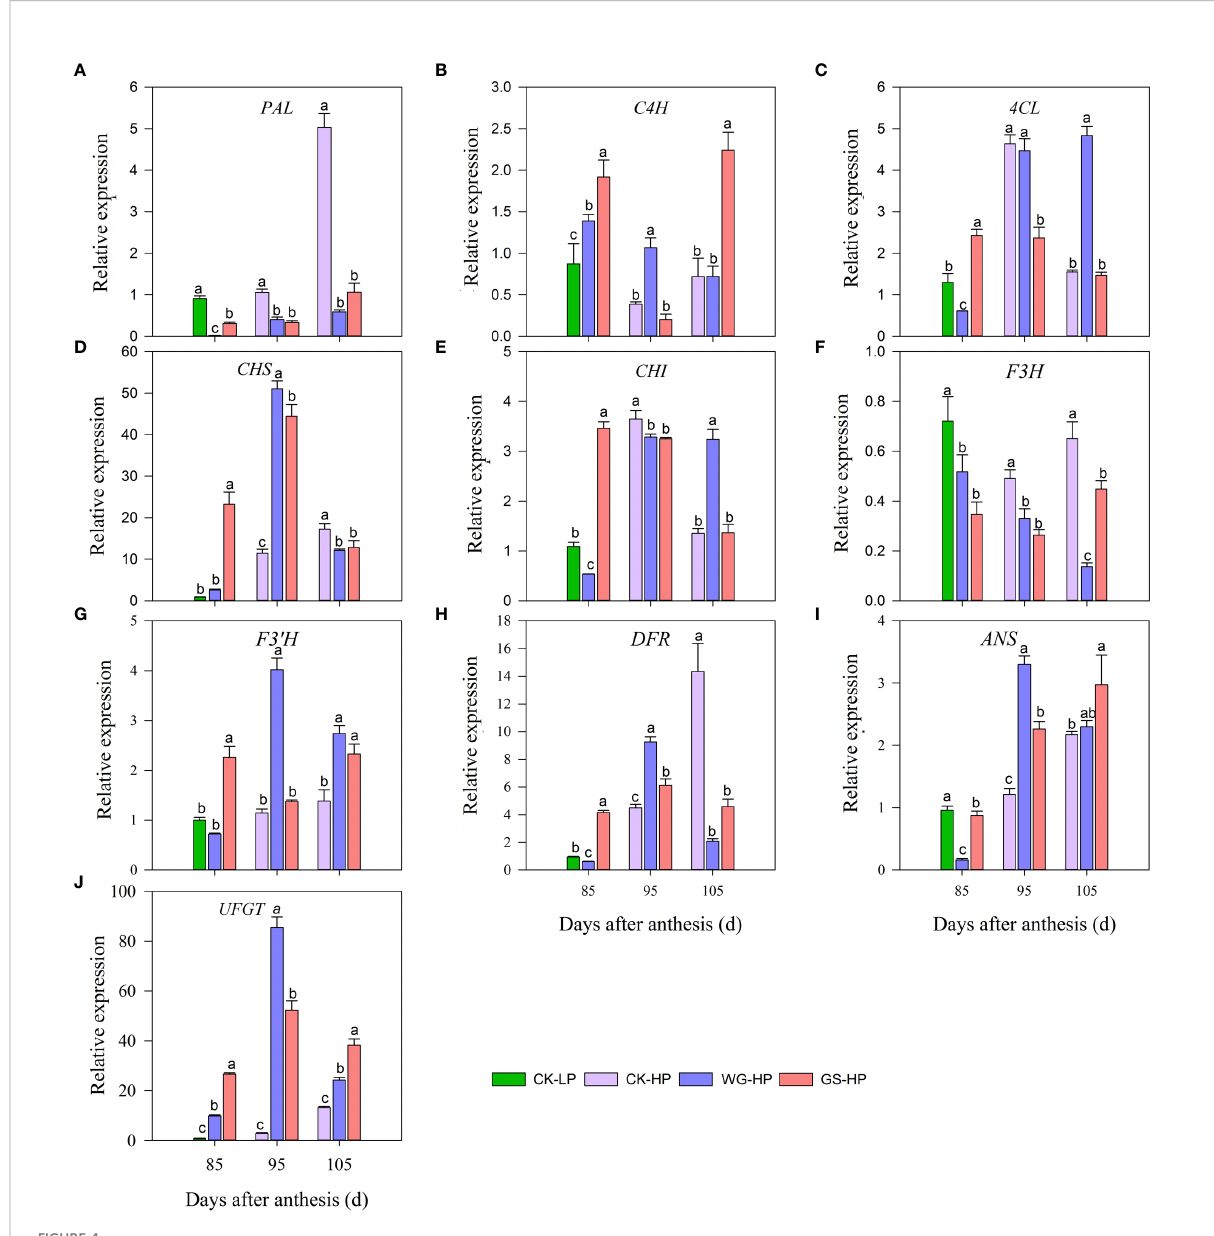
FIGURE 4 Transcript levels of anthocyanin-related genes in different treatments. CK-LP means green skin of ‘ Yinhongli ’ plum, the rest are red skin. Values are mean ± SD (n =3). Different letters indicate signi fi cantly different values at p < 0.05. Phenylalanine ammonialyase, PAL (A) , namate-4- hydroxylase, C4H (B) , 4-coumaroyl: CoA-ligase, 4CL (C) , chalcone synthase, CHS (D) , chalcone isomerase, CHI (E) , fl avanone 3-hydroxylase, F3H (F) , fl avanone 3 ′ -hydroxylase, F3 ’ H (G) , dihydro fl avonol 4-reductase, DFR (H) anthocyanidin synthase, ANS (I) ; UDP-glucose: fl avonoid 3-O- glucosyltransferase, UFGT (J)